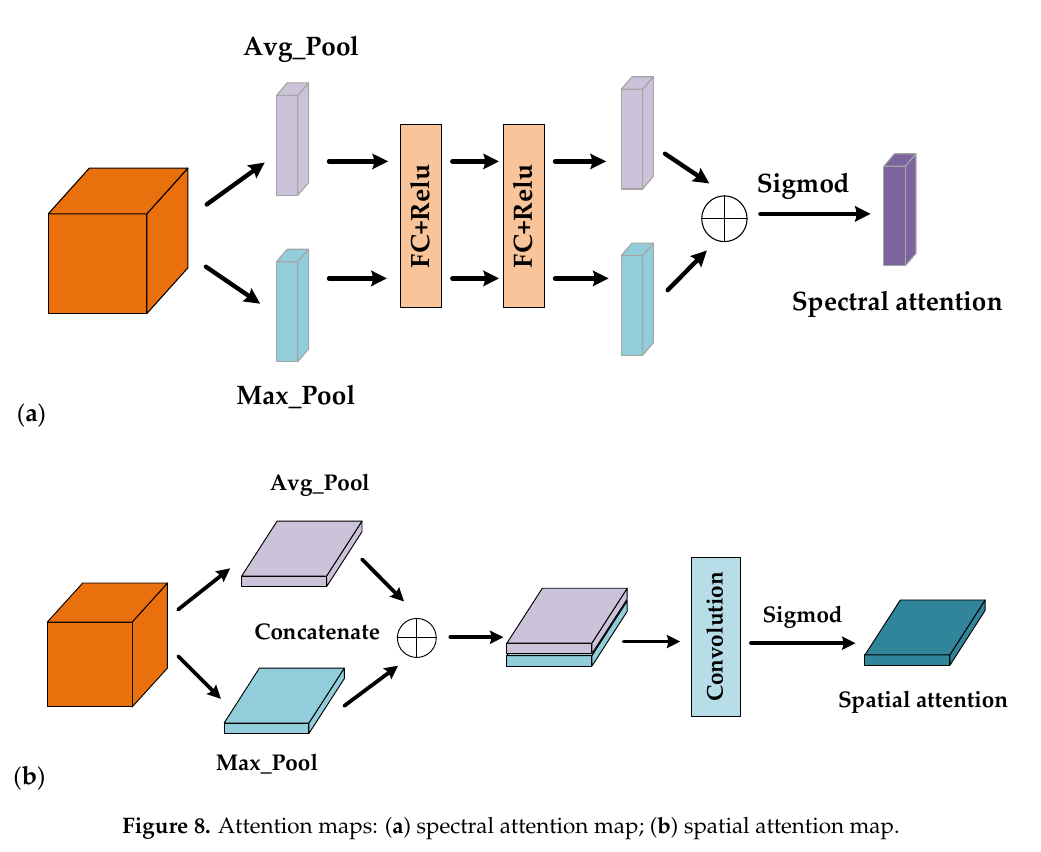
Figure 8. Attention maps: ( a ) spectral attention map; ( b ) spatial attention map.